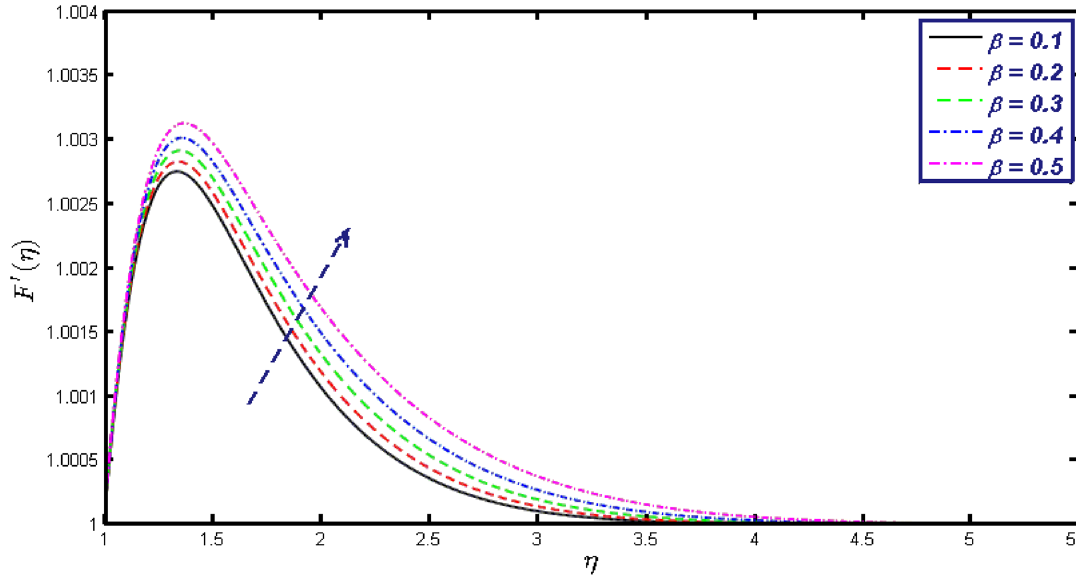
Figure 3. Velocity field for different values of β .